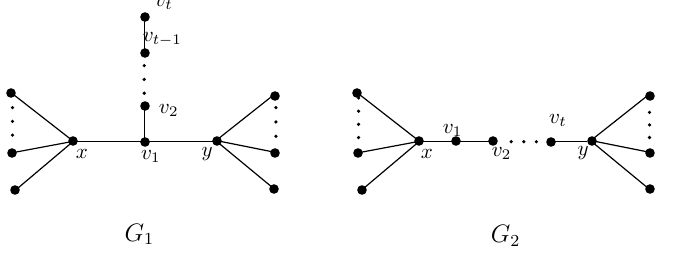
Figure 4. Transformation